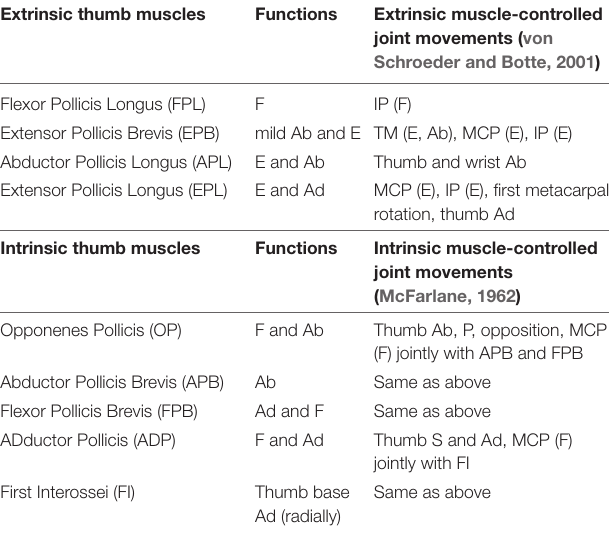
TABLe 2 | Thumb extrinsic and intrinsic muscles ( Figures 3 and 4 ) with corresponding thumb joint movement controls based on anatomical studies (F-Flexion, E-Extension, Ab-Abduction, Ad-Adduction, P-Pronation,